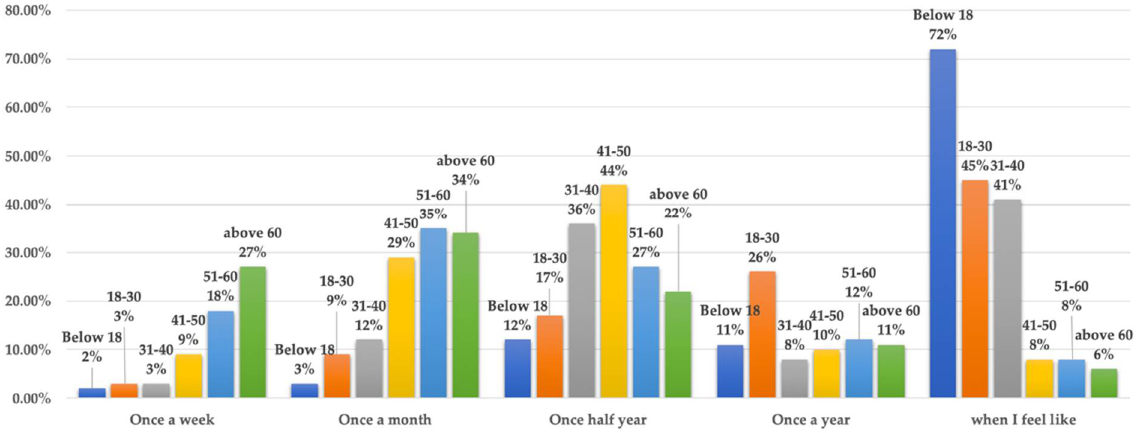
Figure 8. Frequency of receiving healthcare services of women across different ages.